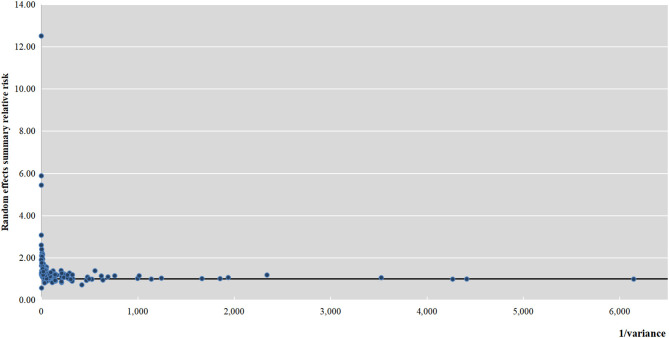
Association of meta-analysis summary effect sizes with inverse of the variance.